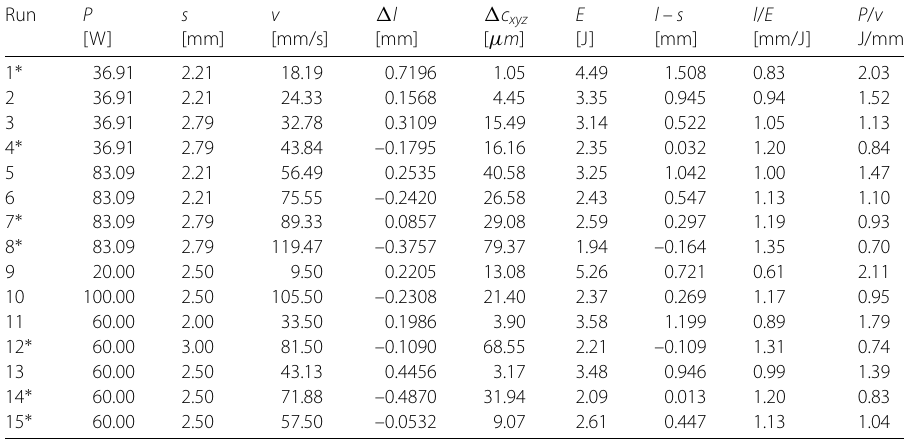
Table 2 Case Study 1: Results of initial experimental design and derived quantities Run